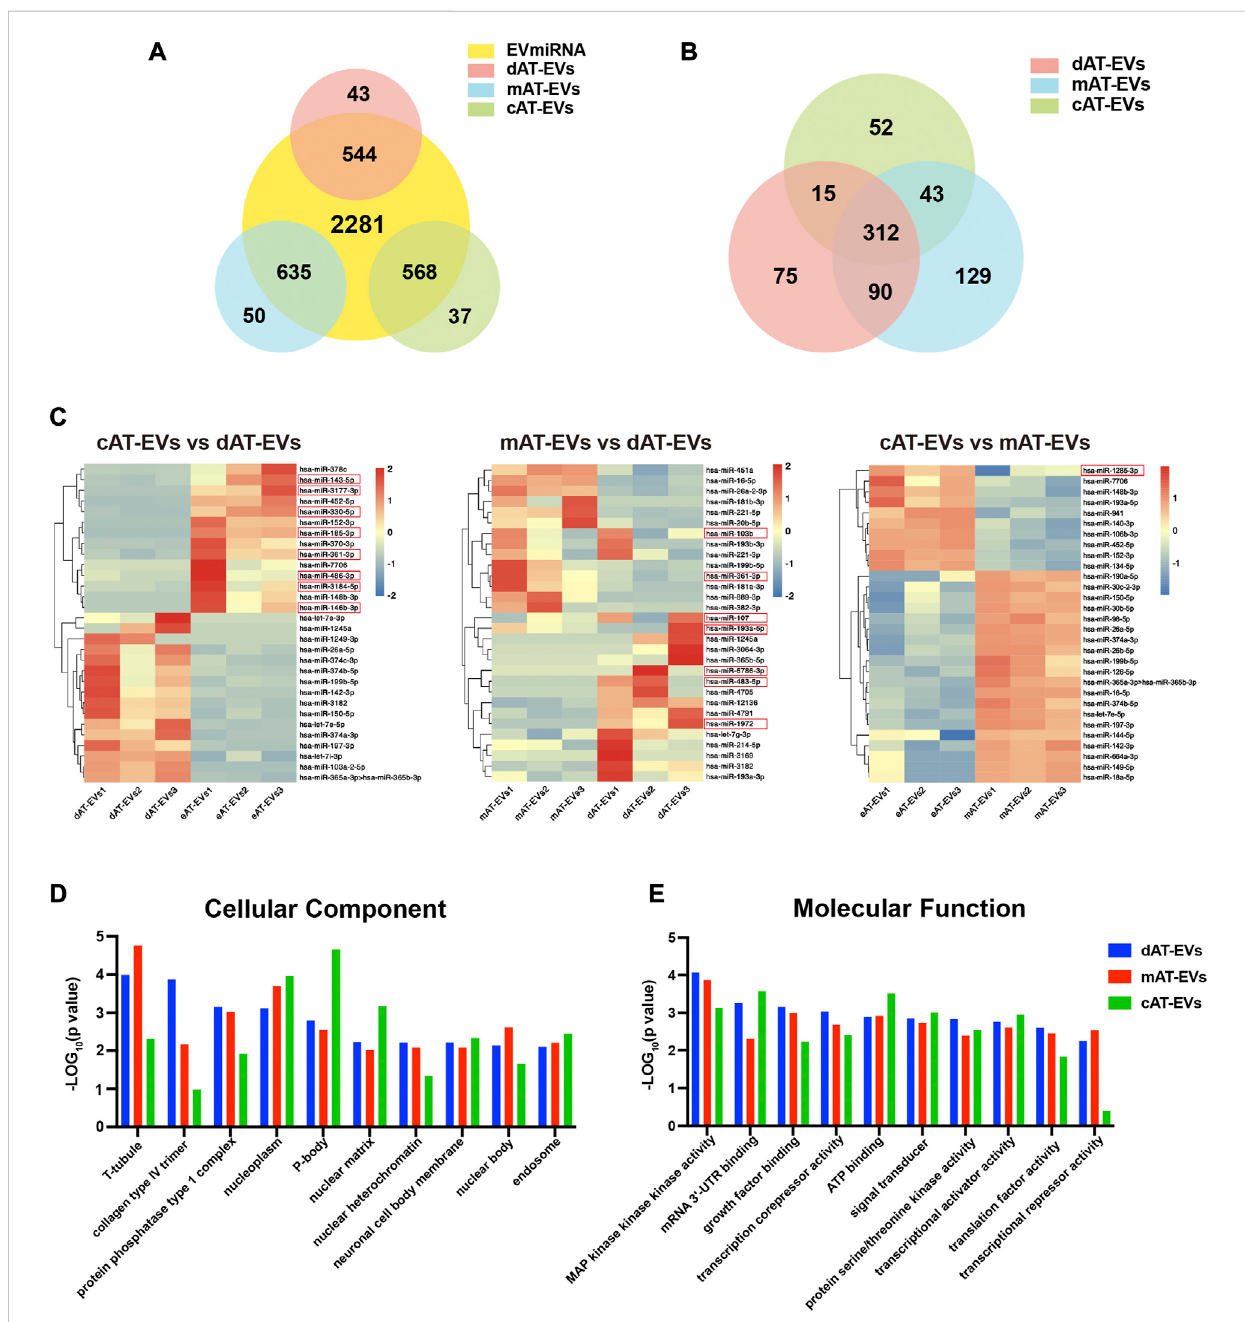
FIGURE 9 Bioinformatics analysis of miRNA enriched in AT-EVs (A) Venn diagram illustrating the number of miRNAs in dAT-EVs, mAT-EVs, and cAT-EVs, respectively, overlappingwith those intheEVmiRNA database. (B) Venn diagram illustrating thenumber ofoverlapping miRNAs between dAT-EVs, mAT- EVs, and cAT-EVs (C) Hierarchical clustering of differentially expressed miRNAs (fold change > 2.0 and p < 0.01; unreported miRNAs, as well as those with low TPM values, were omitted) between cAT-EVs and dAT-EVs (left), mAT-EVs and dAT-EVs (middle), and cAT-EVs and mAT-EVs (right), respectively. Rows represent miRNAs, whereas columns represent individual replicates. (D – E) Gene ontology (GO) analysis of predicted differentially expressed genes of cellular components and molecular functions, based on the identi fi ed differentially expressed